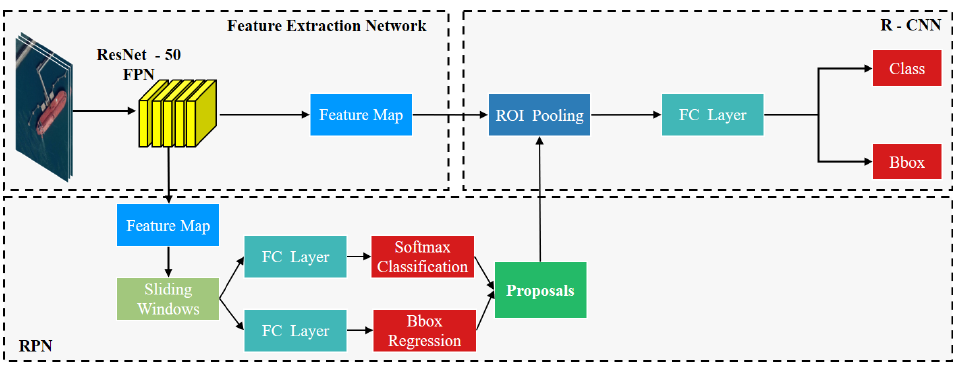
Figure 1. The architecture of faster-RCNN network.